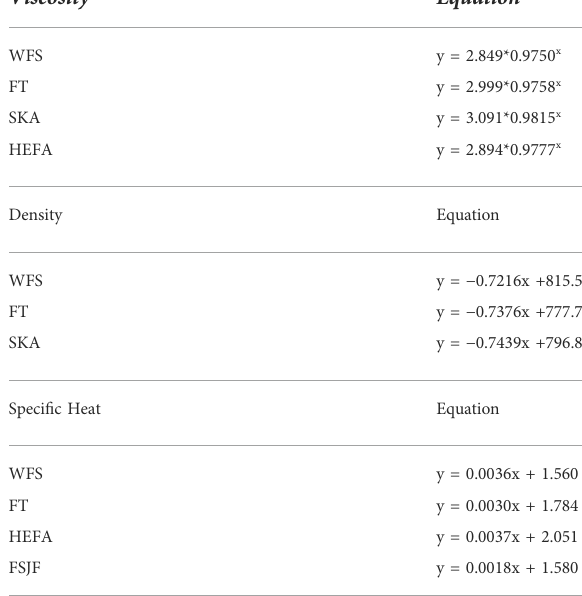
TABLE 7 Thermophysical property relations for